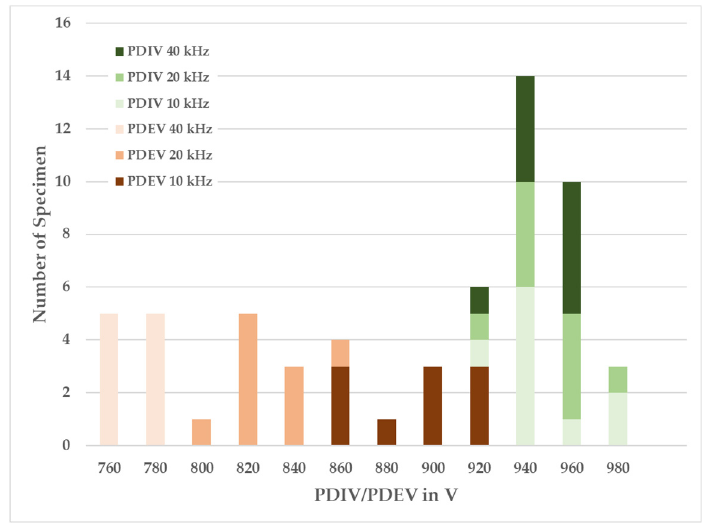
Figure 14. PDIV and PDEV of ten twisted pair specimen at different switching frequencies [155].